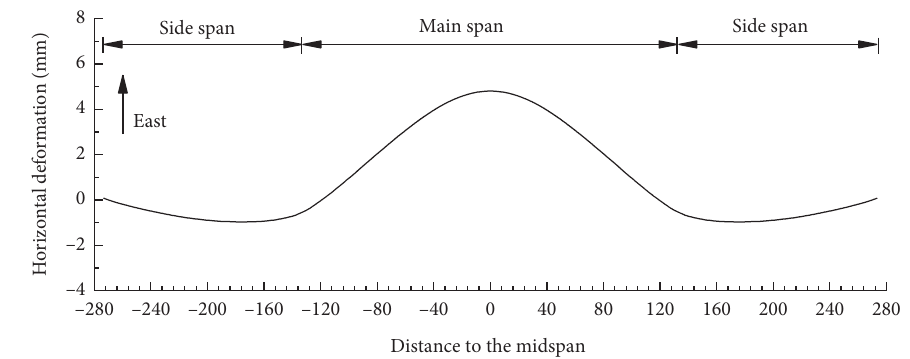
Figure 22: Horizontal deformation. Table 5: MMTS in the deck, webs, and bottom slab (unit: